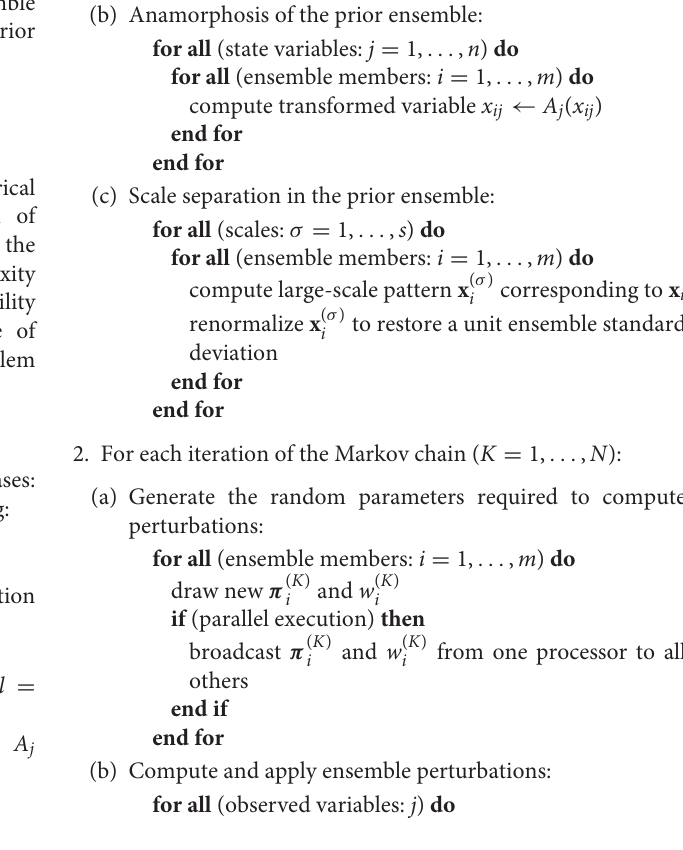
(b) Anamorphosis of the prior